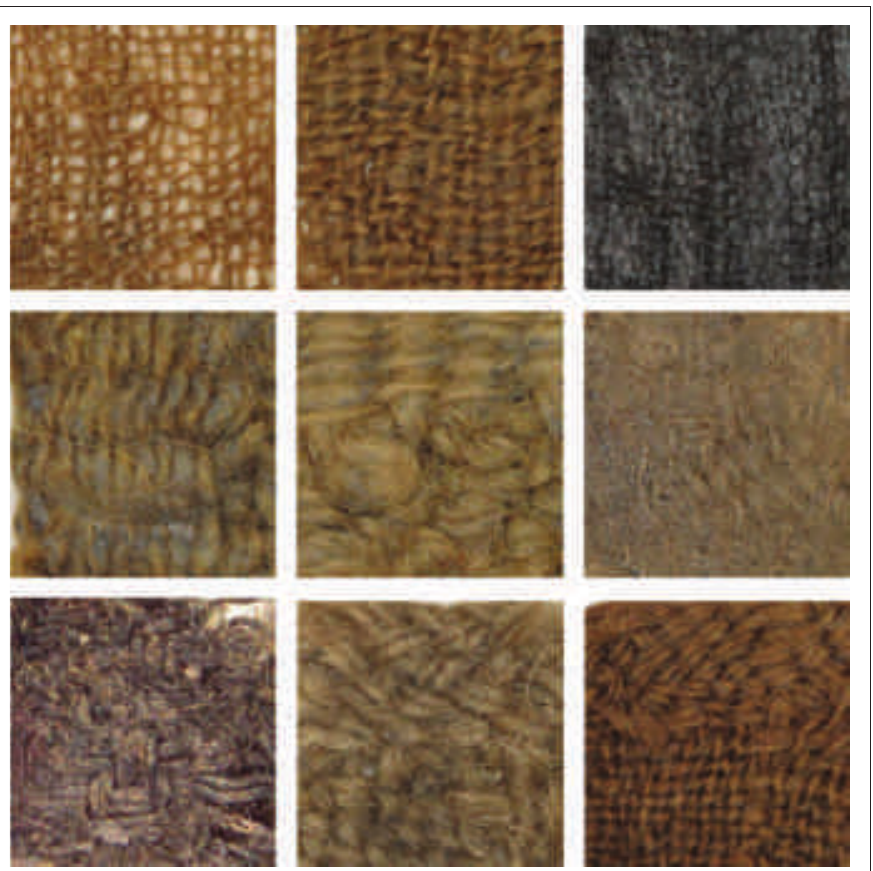
Figure 8 Bronze Age textiles showing the range of weave types